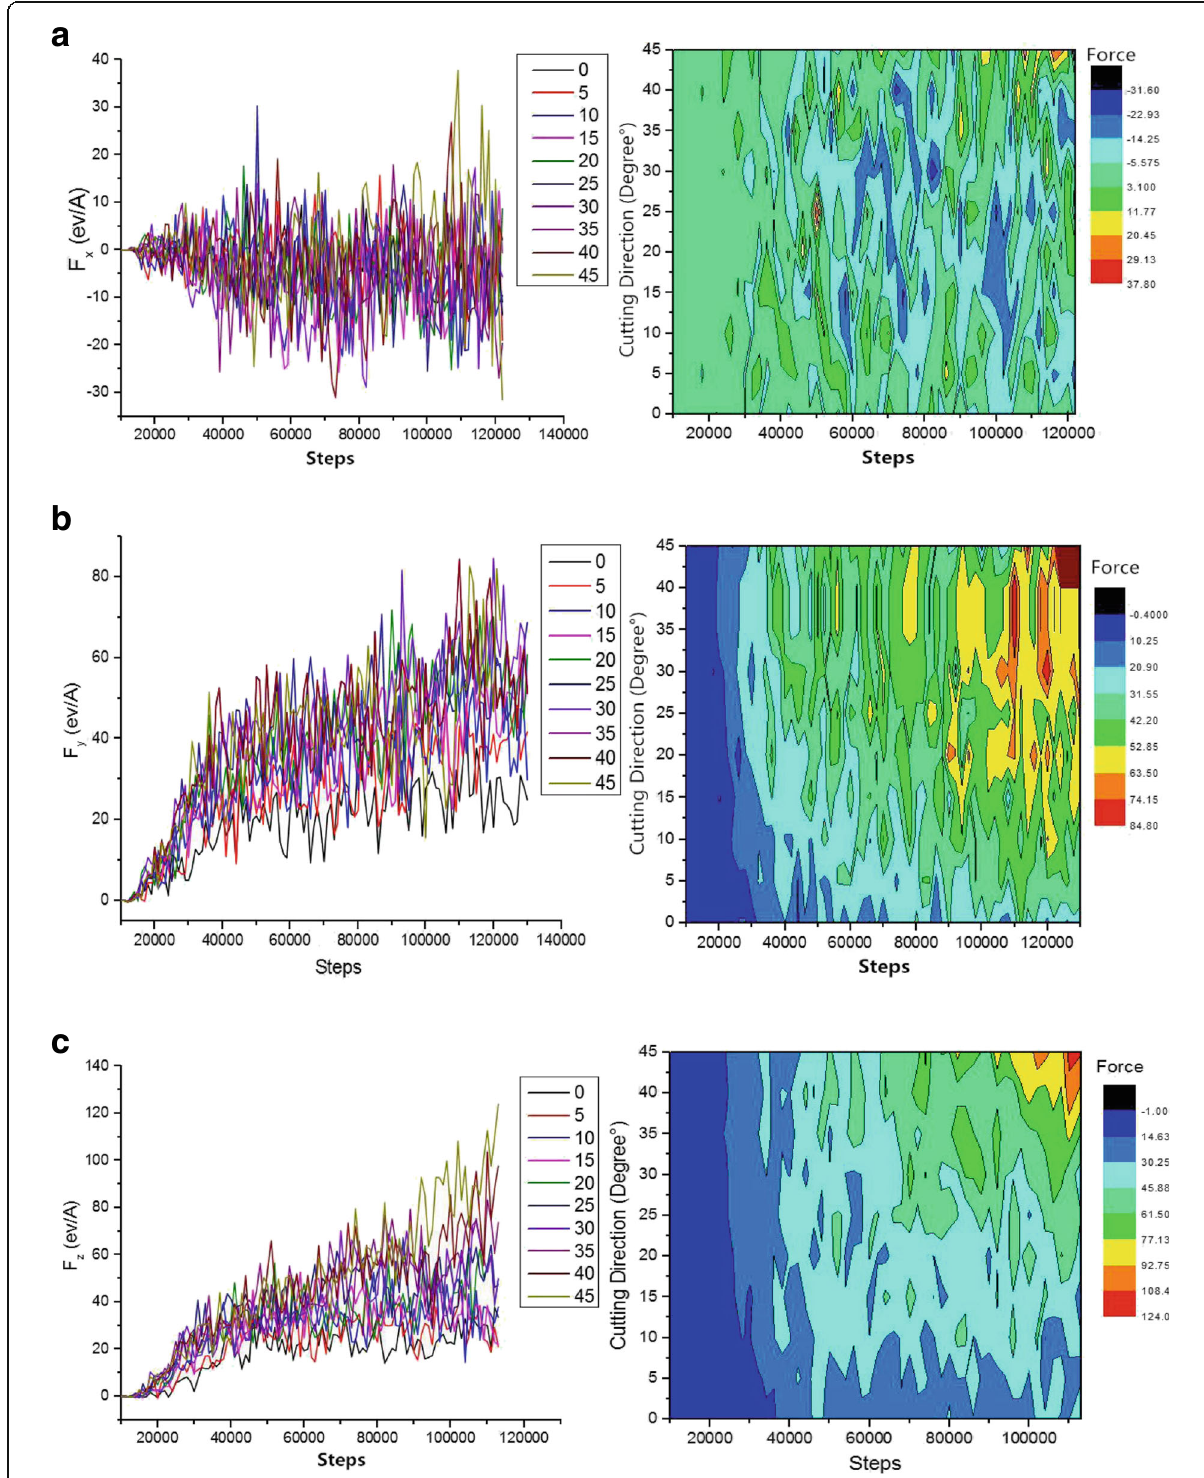
Fig. 6 How cutting angle and simulation step size affect the cutting force. Figure 6 shows SiC abrasive cutting force and the cutting angle and simulation step diagram, with increasing cutting depth, the number of the crystal structure of destruction increases, the maximum value of the fluctuation of cutting force also becomes larger. a [100] direction of the cutting force. b [010] direction of the cutting force. c [001] direction of the cutting